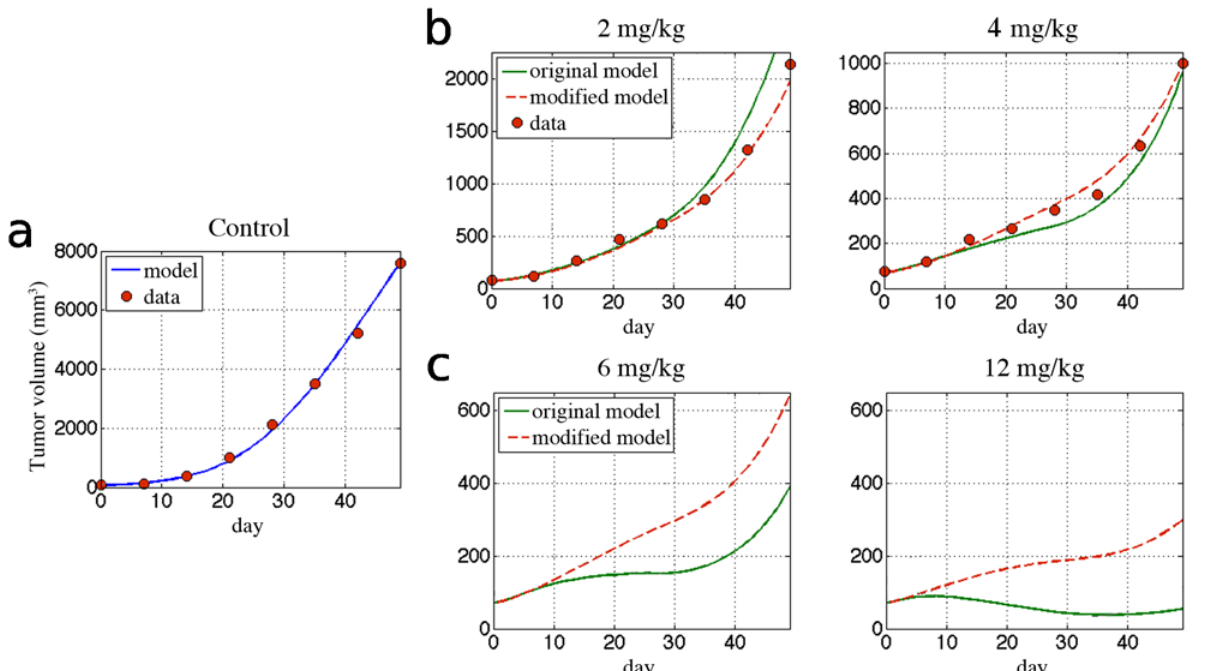
Fig 1. Fitted model curves and predicted tumor response to different doses of bevacizumab. Control data derived from [14] and parameters in Table 1. (a) Control data and the fitted model curve using Equations. C1, C2. (b) Treatment data together with the solutions to original (Equations. C1, O1) and modified (Equations. C1, M1) models. (c) Response of tumor for higher doses of bevacizumab: 6 mg/kg and 12 mg/kg